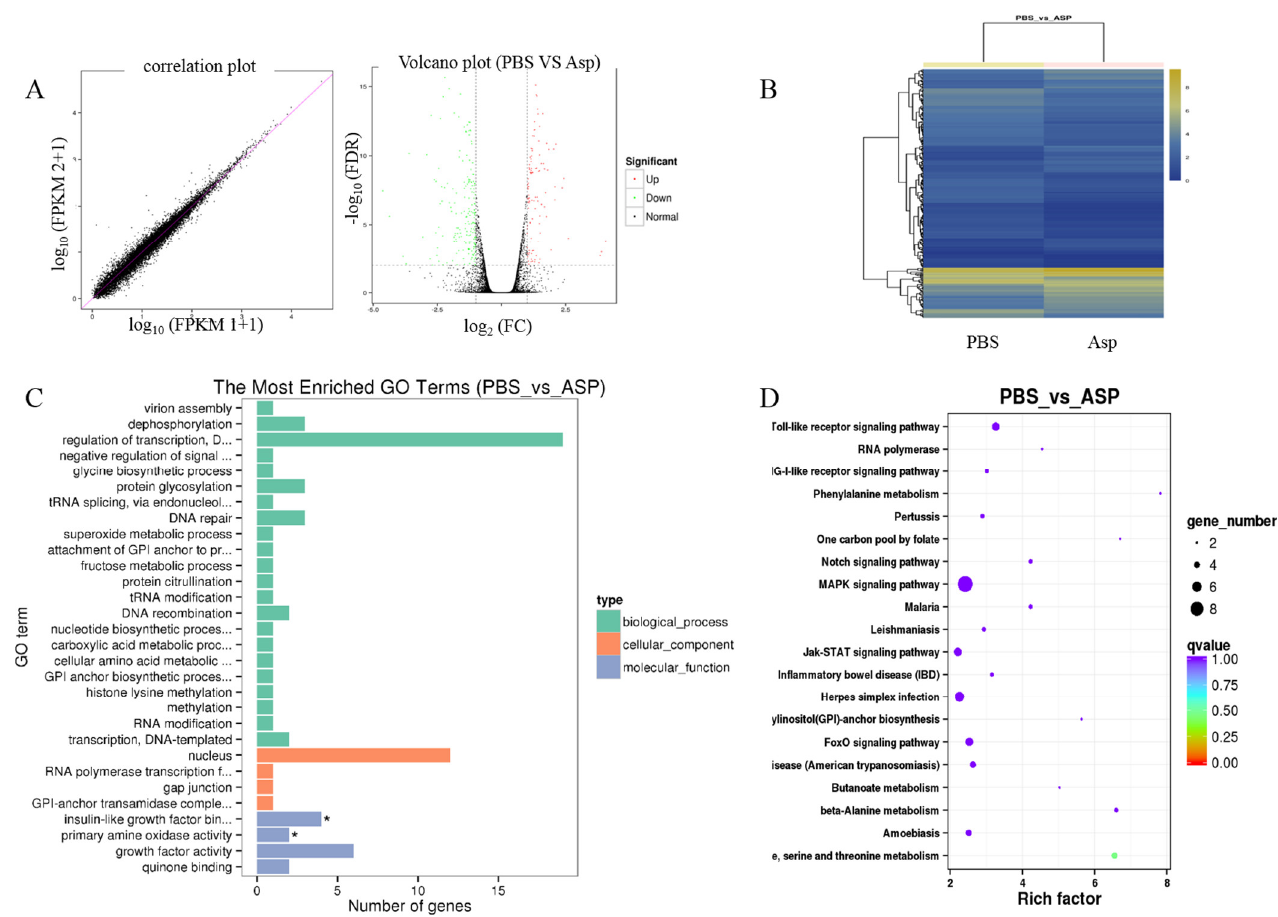
Figure 3. Gene expression profiling using RNA-seq. ( A ) Scatter plots of all expressed genes. Statistics for upregulated and downregulated genes among PBS vs. Asp. ( B ) Hierarchical clustering of differentially expressed genes. ( C ) GO functional classification on DEGs for each pairwise. ( D ) Scatter plot of the top 20 KEGG enrichment results of DEGs in each pairwise comparison. Differentially expressed genes were defined according to the combination of the absolute value of log 2 -Ratio ≥ 1 and FDR ≤ 0.001 The data are shown as the means ± SD of three biological replicates, * p < 0.05. Genes usually interact with each other to play roles in certain biological